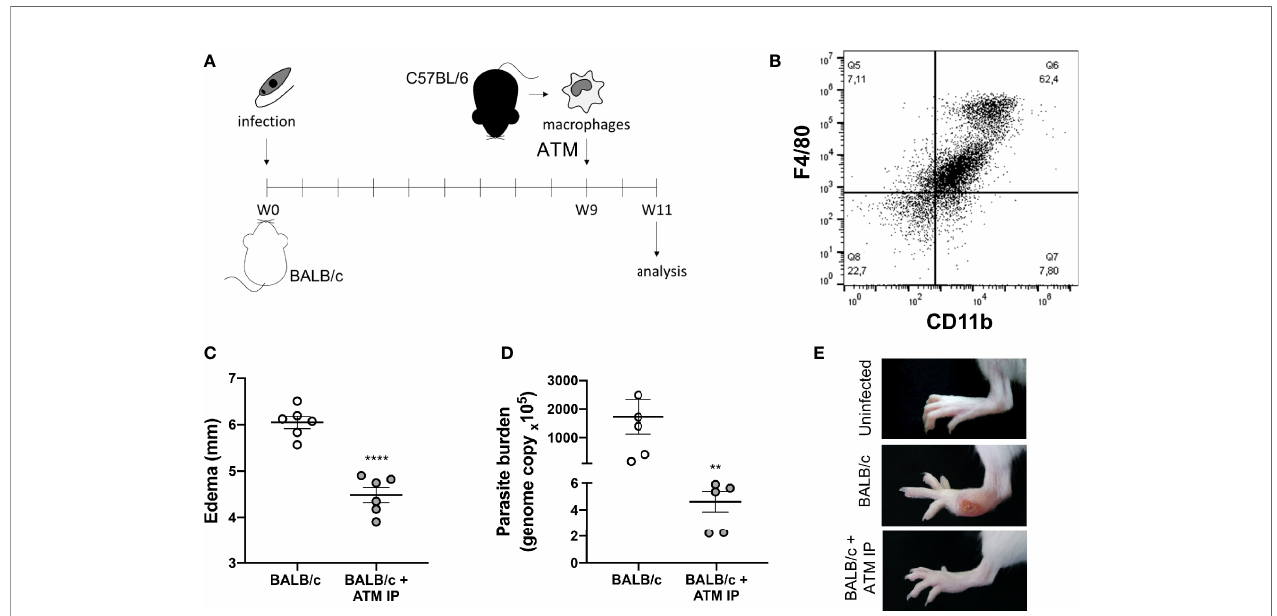
FIGURE 7 | Adoptive transfer of macrophages (ATM). (A) Representative scheme of the experimental design: BALB/c mice were infected with L. amazonensis and, after 9 weeks, they received peritoneal macrophages isolated from C57BL/6 mice intraperitoneally. (B) Dot plot showing the macrophage markers (F4/80 + / CD11b + ) in the peritoneal cells from non-infected C57BL/6 mice. (C) Paw edema of mice that did not receive adoptive transfer of macrophages (BALB/c) and mice that received intraperitoneal ATM (BALB/c + ATM IP) after 11 weeks of infection. (D) Parasite burden and (E) representative photographs of mice paws after 11 weeks of infection. Data from (C, D) represent the mean ± SEM of fi ve mice groups. ** Signi fi cant difference in relation to the group that did not receive ATM, p ≤ 0.01, ****p ≤ 0.0001.